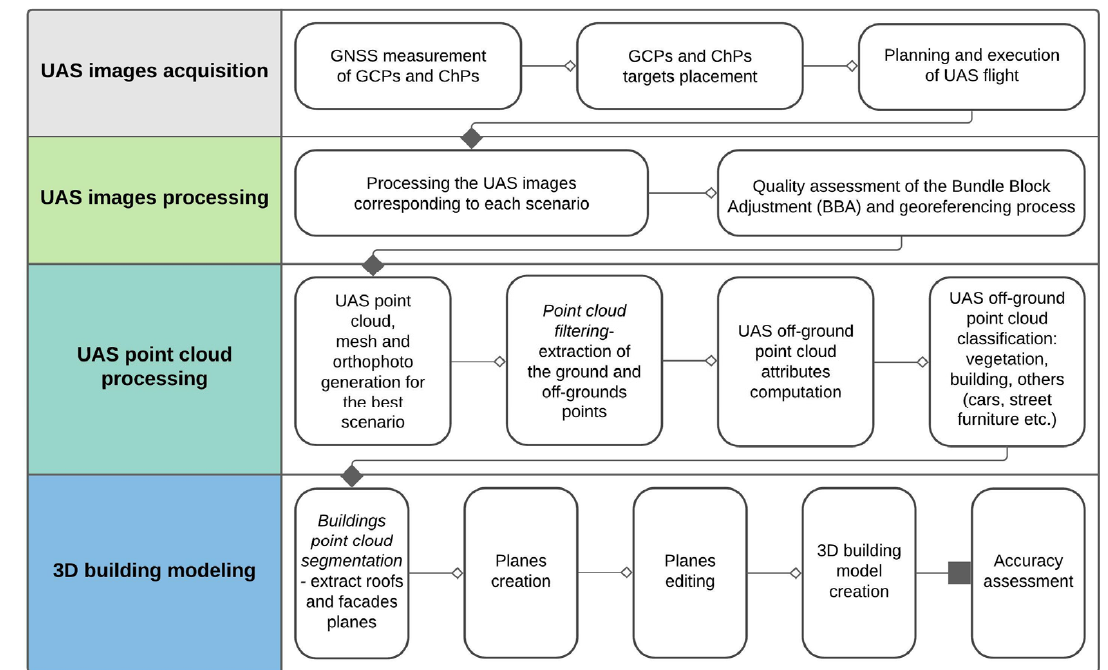
Figure 2. Flow cart of research methodology.